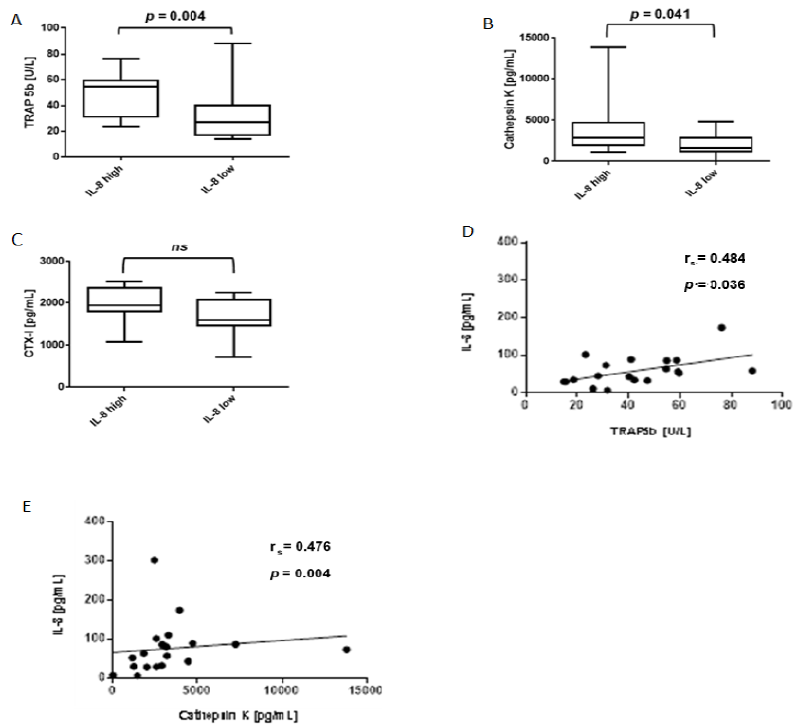
Figure 3. Concentrations of TRAP5b, cathepsin K and CTX-I in bone marrow containing high or low levels of IL-8. ( A – C ) Levels of TRAP5b, cathepsin K and CTX-I in IL-8-low and IL-8-high bone marrow samples (description in the text), n = 23/11; Comparisons were performed using two-tailed Mann– Whitney U test; ns, not significant; ( D–E ) Correlation between IL-8 and TRAP5b ( D ), and cathepsin K ( E ) concentrations in anti-CCP Abs-positive bone marrow, n = 19; the relationships between variables were measured using the Spearman’s rank correlation coefficient. TRAP5b, tartrate-resistant acid phosphatase 5b; CTX-I, C-terminal telopeptide of type I